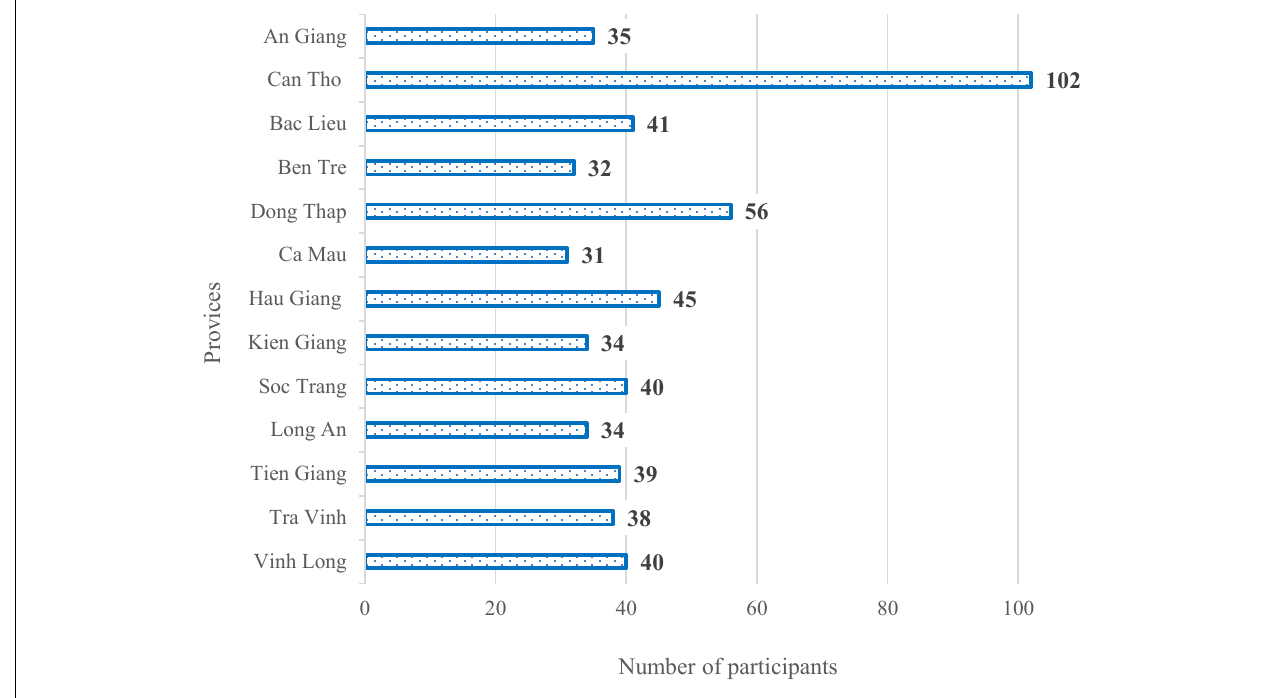
FIGURE 2 | Distribution of participants by provinces.